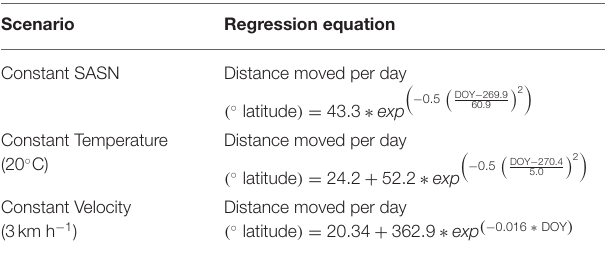
TABLE 3 | Non-linear regression equations predicting distance monarchs would move per day, between DOY 229 and 296 (17 August–23 October), for three pacing